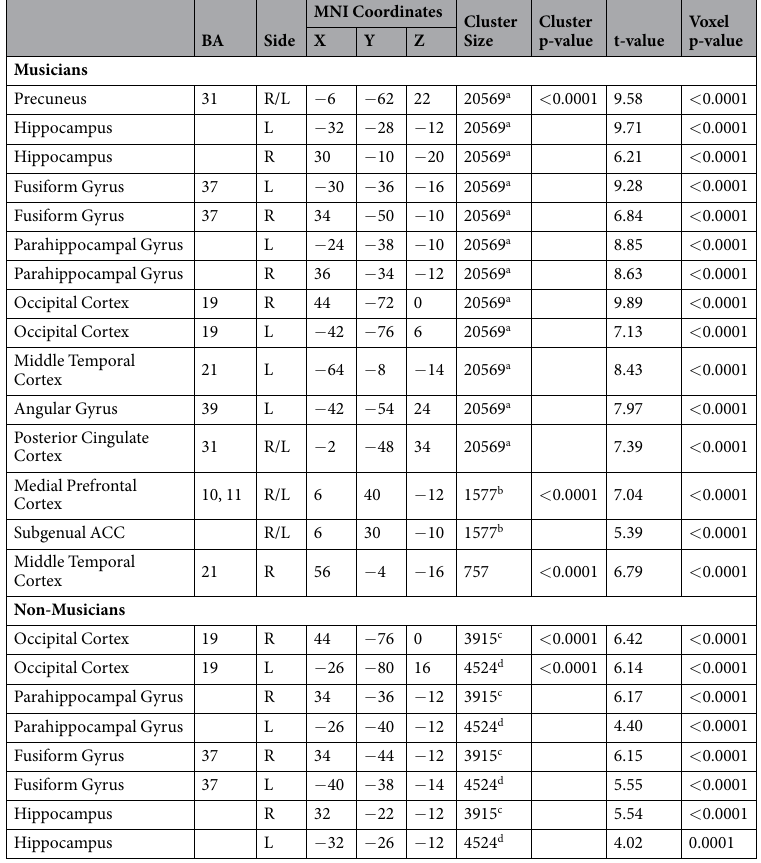
Table 4. Brain regions showing significant within-group activations in the “Repeat > Improvise” contrast. ACC, Anterior Cingulate Cortex; BA, Brodmann Area; R, Right; L, Left; a,b,c,d indicates part of the same cluster. All results survived the Alphasim correction for multiple comparisons.